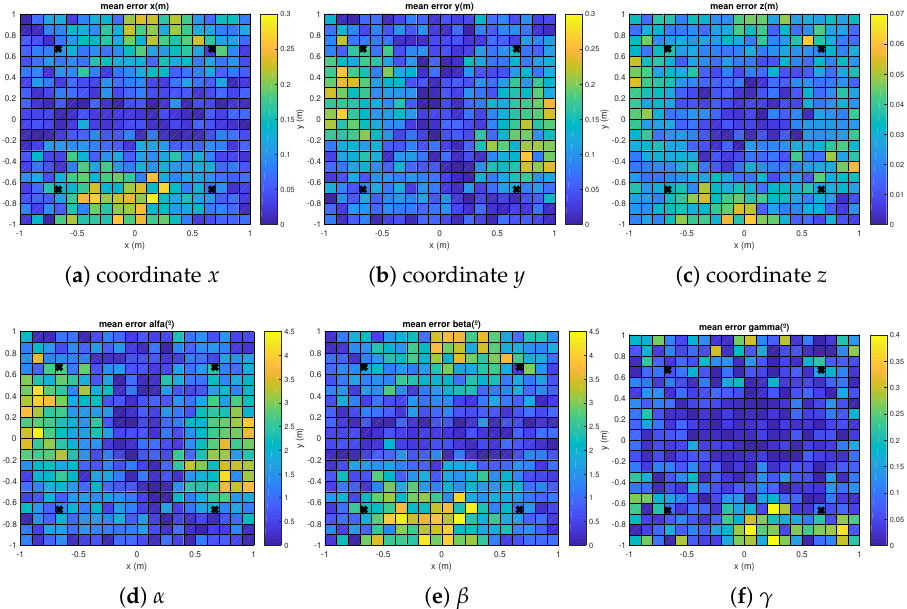
Figure 5. Mean absolute errors in the grid of considered points in the floor for the RPnP algorithm and a rotation in the Z axis γ = 120 ◦